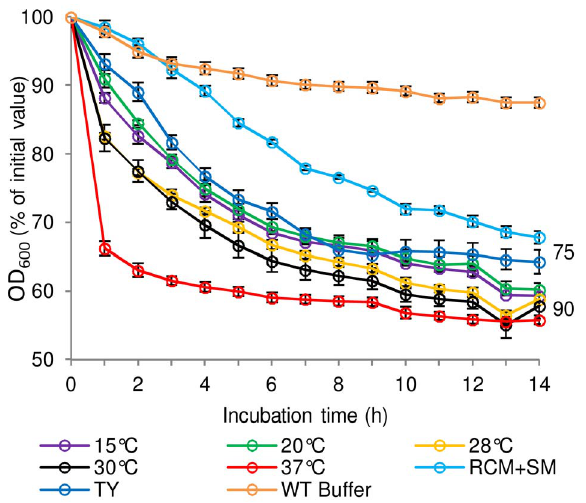
Figure 2. The effect of spore production environment on subsequent germination of C.sporogenes spores. For germination tests, spores were incubated in 20 mM Tris buffer, pH 7.4, L-alanine (100 mM), L-lactate (50 mM) and NaHCO 3 (50 mM) at 30 u C. Spores were produced in CMB at different temperatures; 15 u C, 20 u C, 28 u C, 30 u C, 37 u C. Spores were also produced in TY broth at 37 u C and on RCM + SM plates at 37 u C. Spores produced at 37 u C in CMB and incubated in 20 mM Tris, pH 7.4, L-lactate (50 mM) and NaHCO 3 (50 mM) only, were included as a negative control (WT Buffer). Spore germination was confirmed by phase contrast microscopy. Data labels (right) refer to percentage germination observed by phase contrast microscopy at the end of the experiment. Error bars represent the standard deviation of 3 independent experiments.